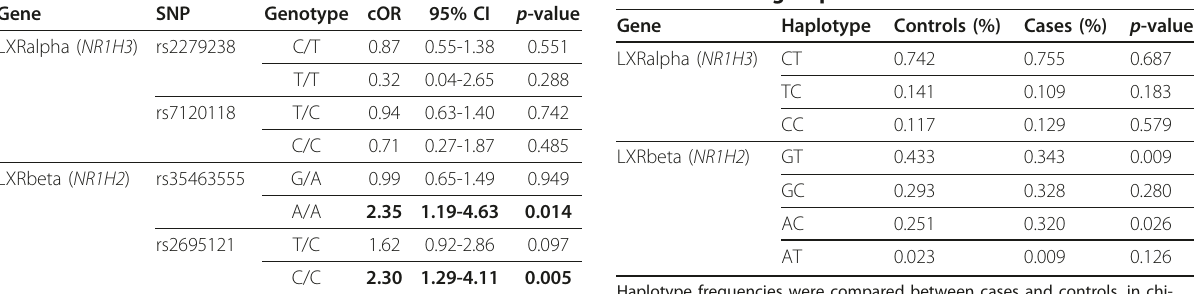
Table 7 Haplotypic prevalence of genotyped NR1H3 and NR1H2 in both groups